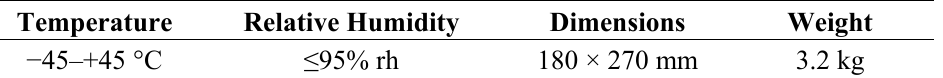
Table 3. DFY-2 Radiometer Suitable Environment and